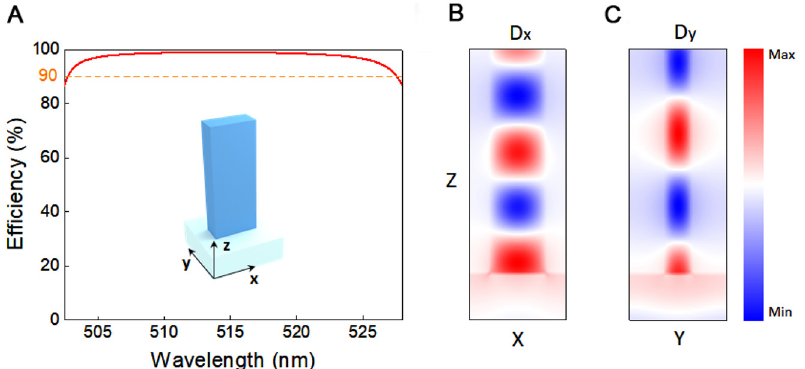
Figure 2: Birefringence effect of a TiO 2 nano fi n metasurface. (A) Simulated and measured polarization conversion ef fi ciency as a function of wavelength. (B and C) Simulated displacement electric fi eld ( x -component and y -component) distribution in a nano fi n at the wavelength 514 nm with circular polarization